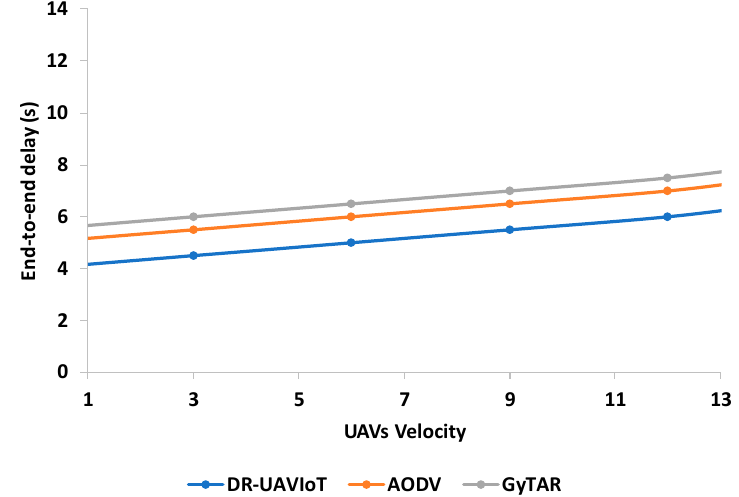
Figure 9. End-to-End Delay in the Presence of Different UAVs Velocities.